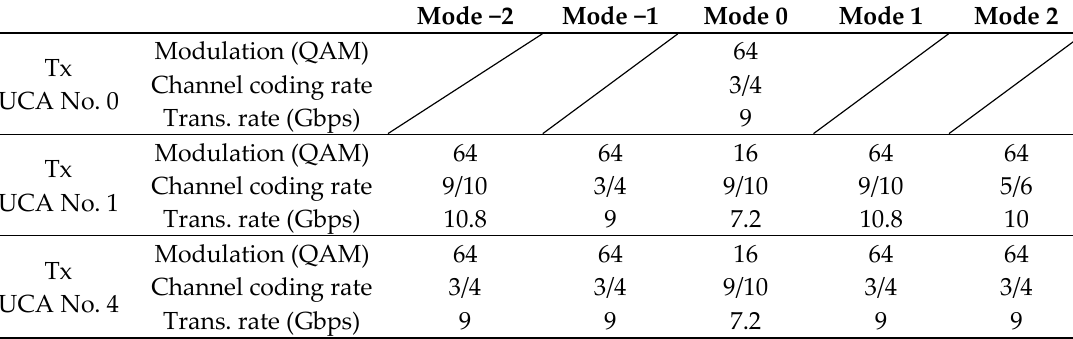
Table 5. Experimental results (OAM-MIMO multiplexing).